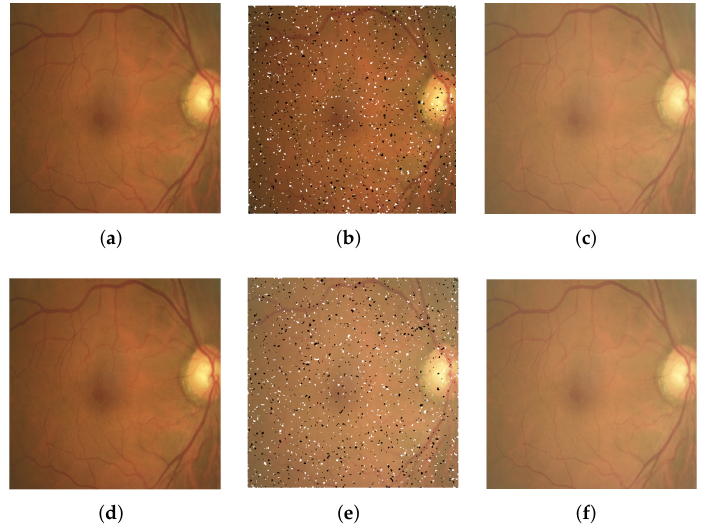
Figure 2. Pre-processing of fundus images. ( a ) Original; ( b ) Salt and pepper; ( c ) Gamma correction; ( d ) Remove noise; ( e ) Gamma correction + Salt and pepper; and ( f ) Gamma correction + Remove